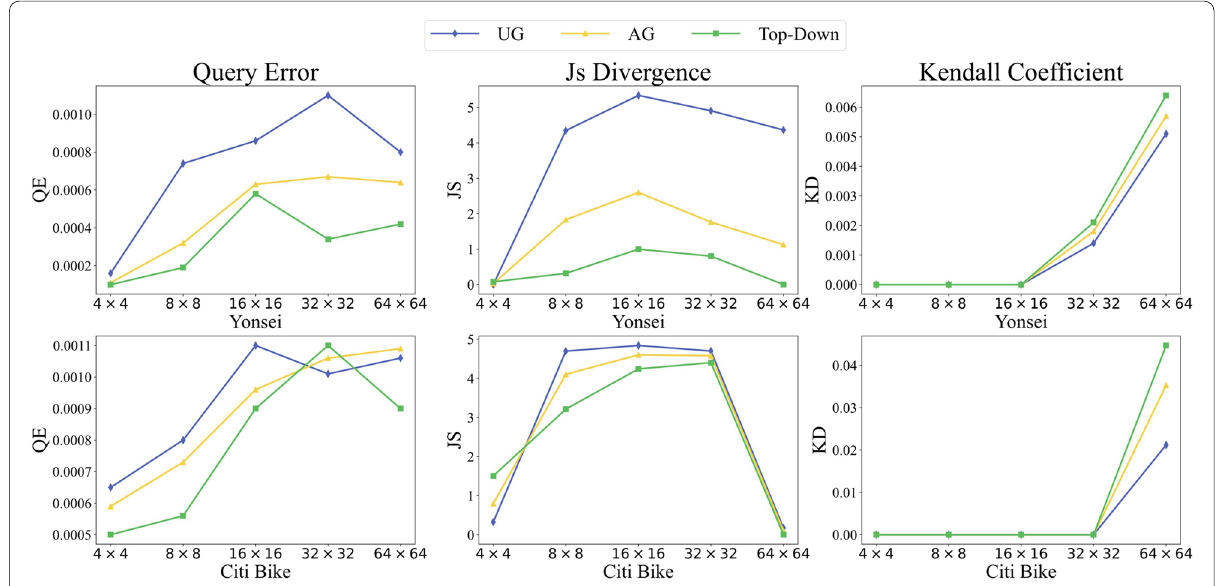
Fig. 7 Visualization average performance of different query